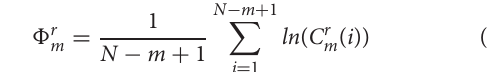
the disease mechanism, which is characterized by an increase of regularity of the series